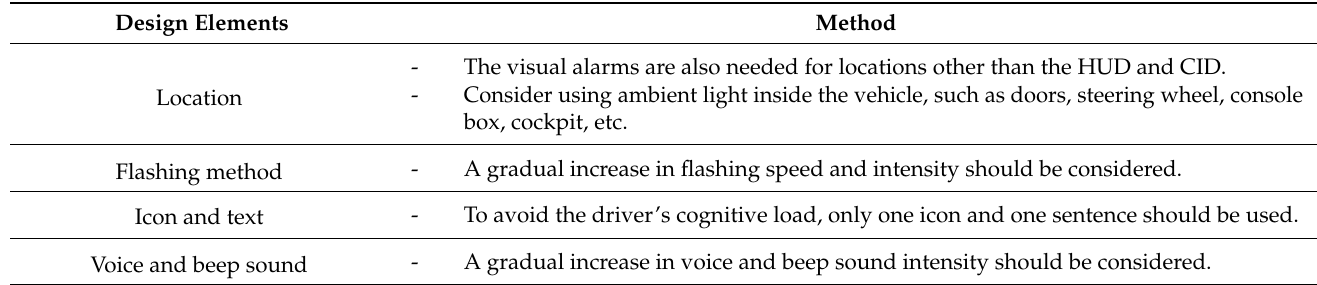
Table 5. Complementary design elements for an advanced